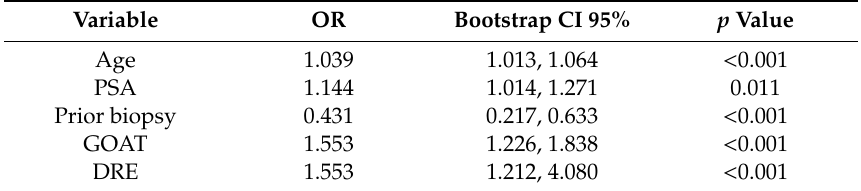
Table 4. Multivariate analysis of the association of plasma GOAT levels with the diagnosis of prostate cancer (PCa) in the patients with a PSA range of 3–10 ng / mL adjusting with common clinical variables. Variable OR Bootstrap CI 95% p Value Age 1.039